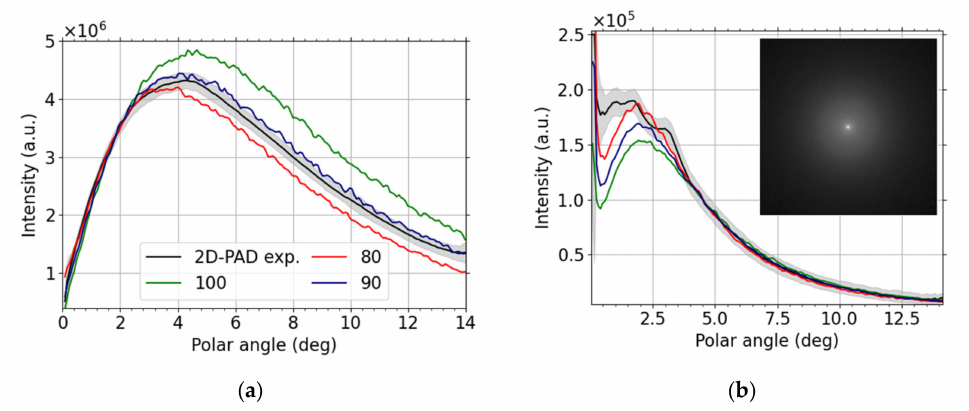
Figure 8. C, ( a ) 15 keV and ( b ) 30 keV, experimental (black with gray error stripe) and theoretical results for different thicknesses based on glassy-carbon MC simulations with 10 6 particles freely propagated to the 2D-PAD plane. The inset shows the corresponding diffractogram with the Debye– Scherrer rings (contrast enhanced by the gamma correction, value Γ = 0.3, the camera length is 39.1 mm).